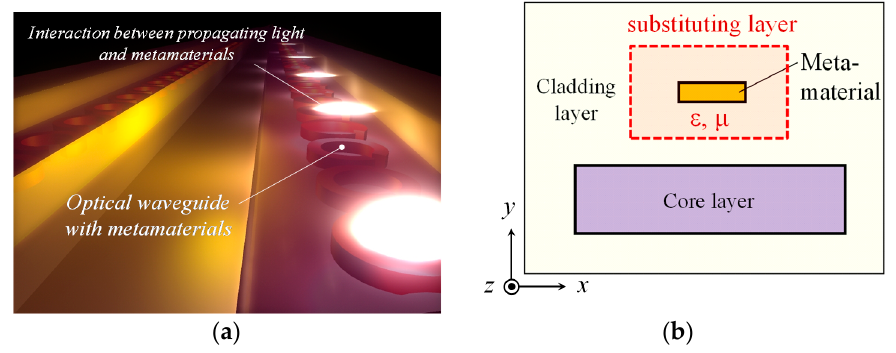
Figure 1. ( a ) Schematic image of optical waveguide with metamaterials on its surface. Magnetic interaction between metamaterials and light moves relative permeability of waveguide away from 1; ( b ) One example of cross section of the waveguide with the substituting layer.